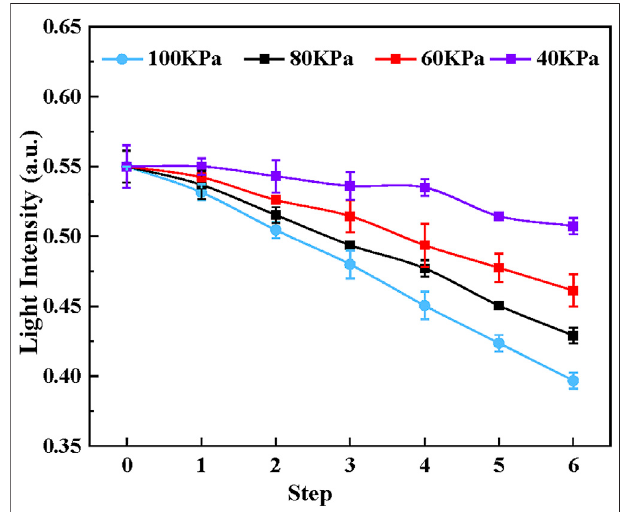
FIGURE10 | The lightintensity oftactel 1withthe pressure step ranging from 40 to 100 kPa.